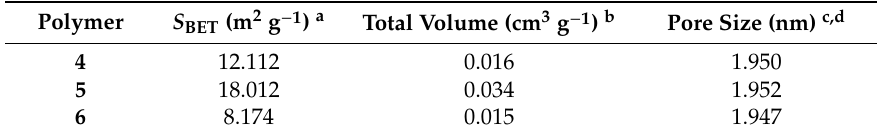
Table 5. Textural properties of polymers 4–6 .